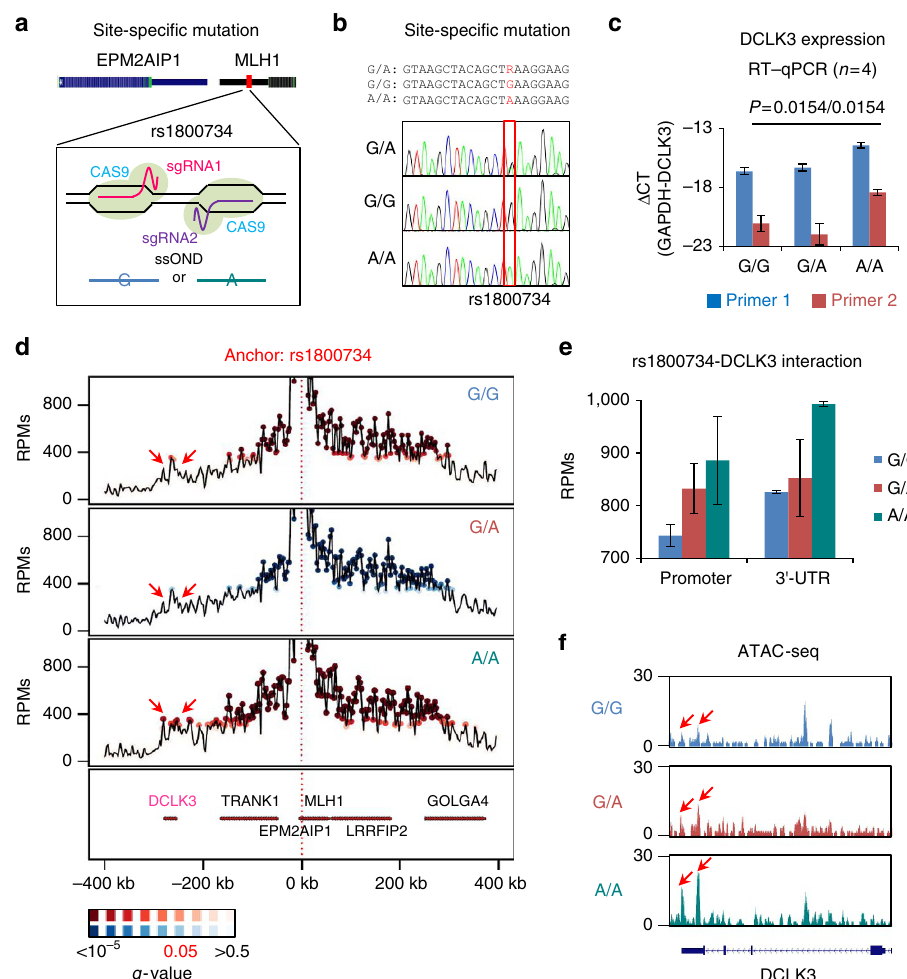
Figure 3 | Molecular regulatory mechanisms of rs1800734 on DCLK3 . ( a ) Isogenic cell lines possessing homozygous mutations (G/G and A/A) at rs1800734 were generated and ( b ) confirmed, and ( c ) the expression of DCLK3 was elevated in the A/A cell line (data are represented as mean and error bars indicate s.d., n ¼ 4 biological replicates per cell line, P -values: Student’s t -test). ( d ) 4C-seq identified chromatin interactions between rs1800734 and the DCLK3 region. ( e ) The A/A cell line showed stronger chromatin interaction than other cell lines (data are represented as mean and error bars indicate s.d., n ¼ 2 biological replicates per cell line). ( f ) The enhanced chromatin interaction results in increased chromatin accessibility at 3 0 -UTR region of DCLK3 in the A/A